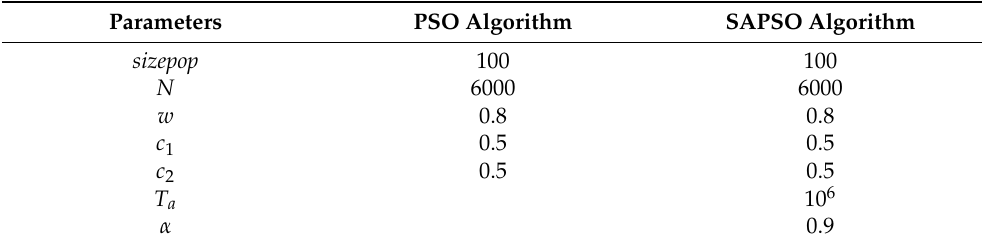
Figure 4. Operation hydrographs of Bashan Reservoir for the 31 July 1964 flood.